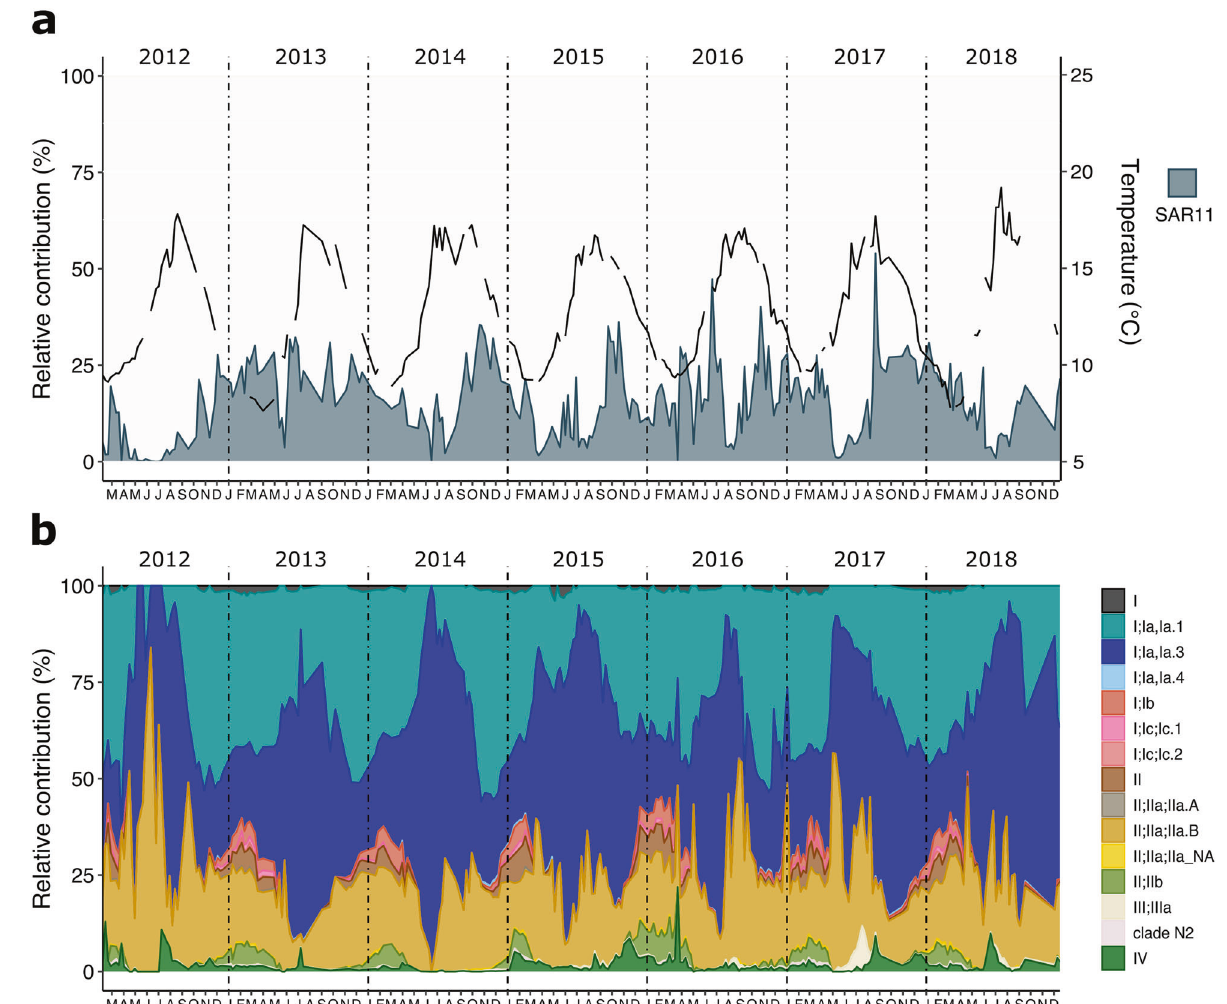
Fig. 2 Monthly relative contribution of surface SAR11 ecotypes through a multiannual 16S rRNA survey at station L4 from the Western English Channel. a Monthly relative contribution of the SAR11 fraction to the total of the amplicon dataset. The black line represents temperature through the sampled years. b Monthly relative contribution of ecotypes to the total SAR11